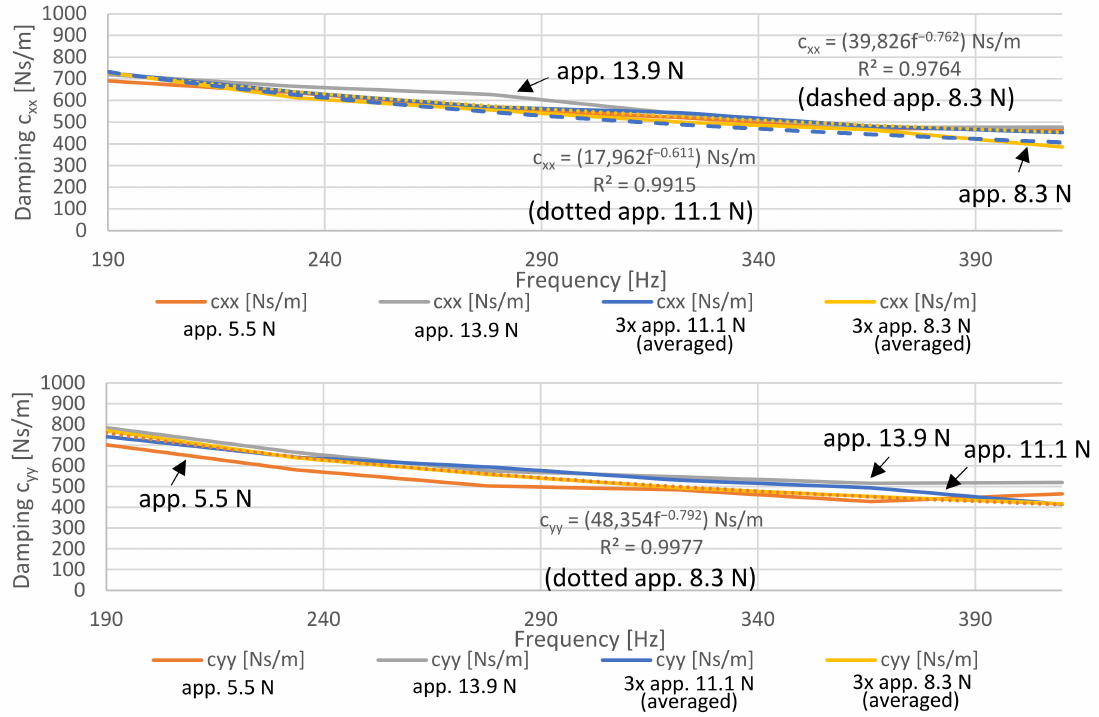
Figure 11. Damping: Displacement controlled (20 µ m); changing static loads between app. 5.5–13.9